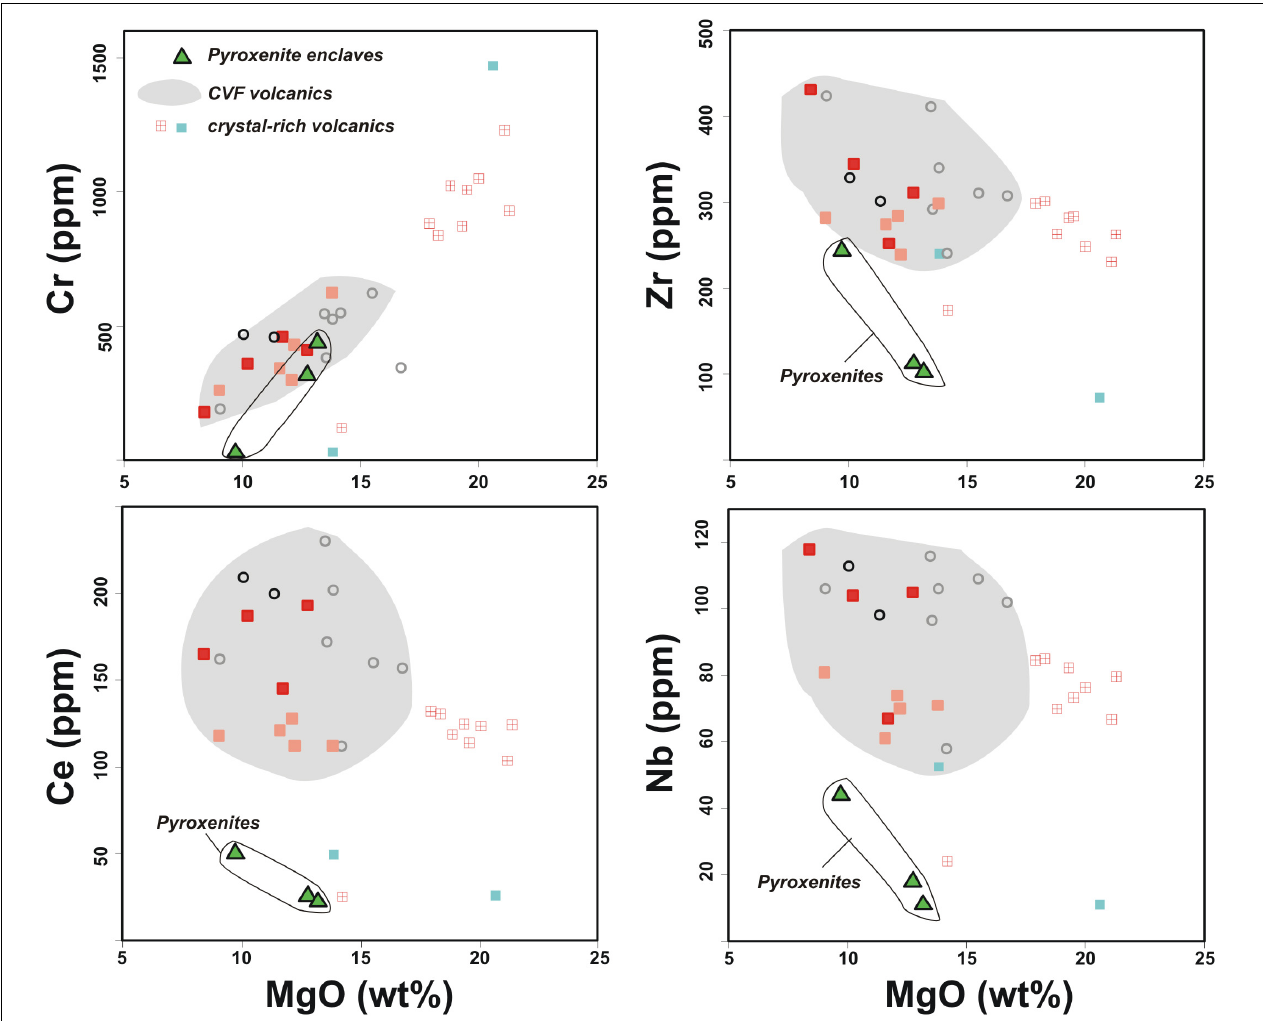
FIGURE 3 | Trace element variation diagrams for the Calatrava Volcanic Field (CVF) rocks and associated pyroxenite enclaves. Same symbols as in Figure 2 . The Calatrava compositional field does not overlap with most of the crystal- and xenolith-rich (contaminated) magmatic rocks from the El Aprisco and the Cerro Pelado volcanic